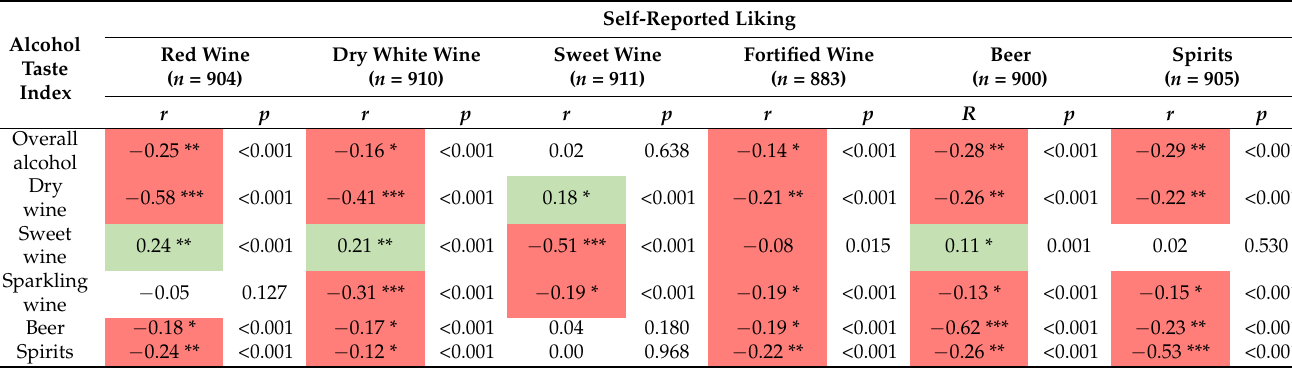
Figure 3. Mean scores for the alcohol taste indices grouped by drinks per day when consuming alcoholic beverages (1 or 2, n = 649; 3 or more, n = 239). Significantly different means from t -tests are indicated with different letters. Table 3. Correlation between alcohol taste statement indices and self-reported alcoholic beverage liking (red wine, dry wine, sweet wine, fortified wine, beer, spirits). Correlation coefficients ( r ) are shaded in green and red to highlight significant positive and negative correlations, respectively. Effect sizes were considered small (*), medium (**), or large (***) when absolute r values exceeded 0.1, 0.2, or 0.3, respectively [59]. (NA = “not